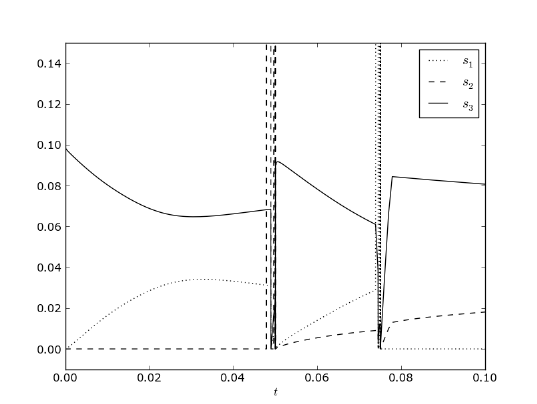
Figure 6. Correcting